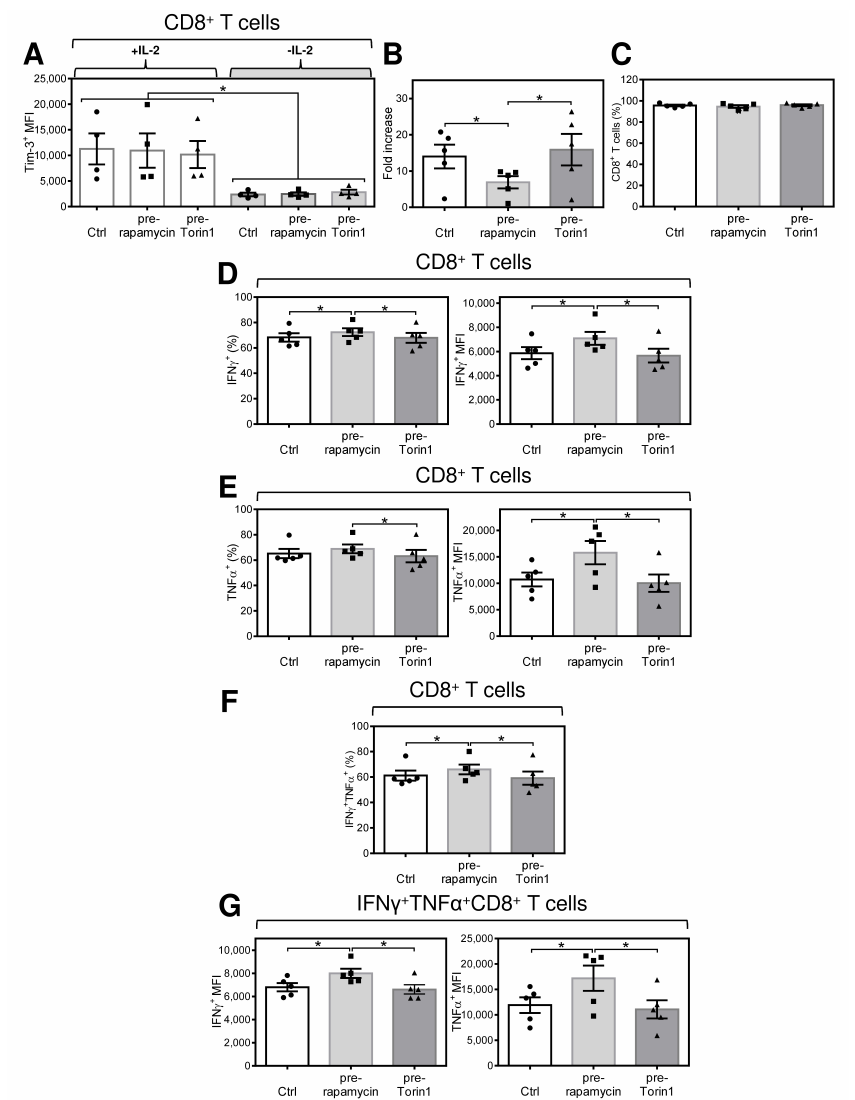
Figure 6. Acute conditioning of expanded CD8 + T cells with the mTOR complex inhibitor rapamycin but not Torin1 prior to antigen rechallenge promotes re-expansion of CD8 + T cells with enhanced production of TNF α and IFN γ after antigen stimulation. The 14-day-expanded lymphocytes were reconstituted and cultured for 18–24 h with IL-2 (80 IU / mL). The cells were pelleted, resuspended in IL-2-containing medium (80 IU / mL) supplemented with 100 nM rapamycin or 100 nM Torin1, and cultured for 18–24 h. The cells were pelleted, resuspended in fresh IL-2-containing medium (80 IU / mL), stimulated with UV-irradiated PC-3 cells as in Figure 1, and 7-day re-expanded and analyzed as in Figure 2. ( A ) The intensity of Tim-3 staining (MFI) of expanded CD8 + T cells after their acute conditioning with rapamycin (pre-rapamycin) and Torin1 (pre-Torin1) prior to antigen rechallenge and re-expansion. ( B ) The cell number fold increase of the 7-day re-expanded lymphocytes not pretreated (Ctrl) or pretreated with rapamycin (pre-rapamycin) or Torin1 (pre-Torin1). ( C ) The proportion of the CD8 + population of T cells in the re-expanded culture. ( D ) The proportion of the IFN γ + population (left panel) and its intensity of staining (MFI) (right panel) of CD8 + T cells. ( E ) The proportion of the TNF α + population (left panel) and its intensity of staining (MFI) (right panel) of CD8 + T cells. ( F ) The proportion of the IFN γ + TNF α + population of CD8 + T cells. ( G ) The IFN γ + (left panel) and TNF α + (right panel) intensities of staining (MFI) of IFN γ + TNF α + population of CD8 + T cells. In ( A – G ), bars represent the mean of values determined in each group, and the significance of di ff erences among the tested groups is indicated (* p < 0.05, n = 5 donors, 1-way ANOVA with the Tukey